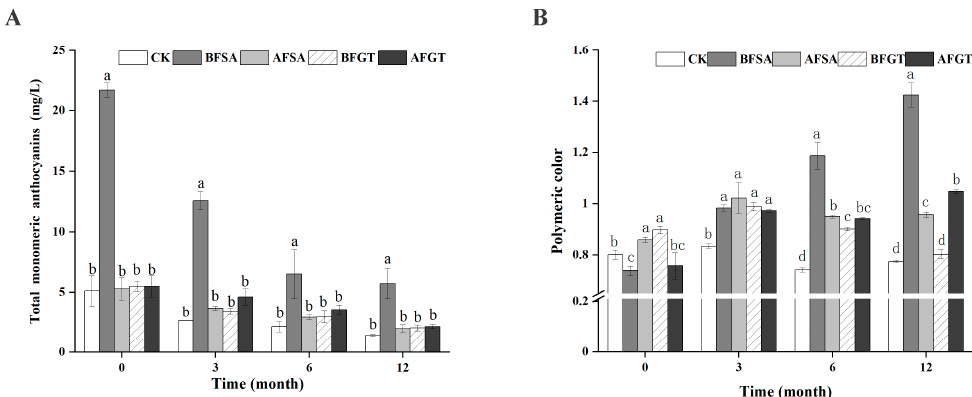
Figure 1. Effects of added sinapic acid and grape tannin on the total monomeric anthocyanins ( A ) and polymeric color ( B ) of cherry wine. Samples with different letters are significantly different ( p < 0.05).